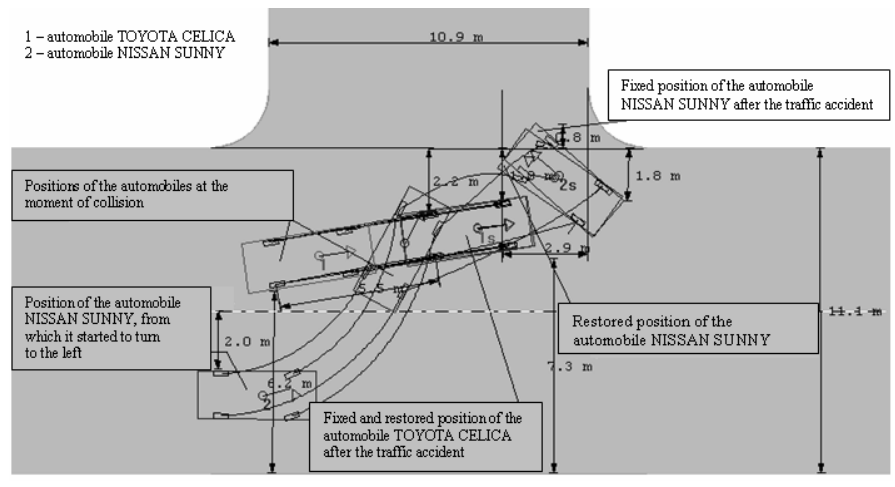
Fig 8. Collision of the automobiles TOYOTA CELICA and NISSAN SUNNY